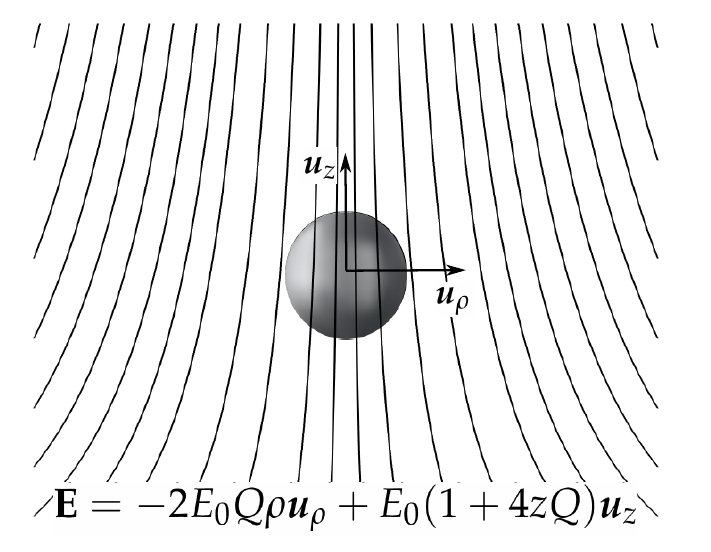
Figure 1. Metal particle subjected to a non-homogeneous electric